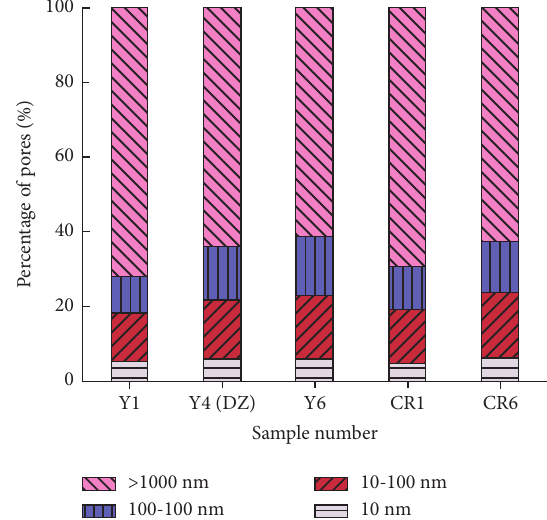
Figure 21: Pore percentage